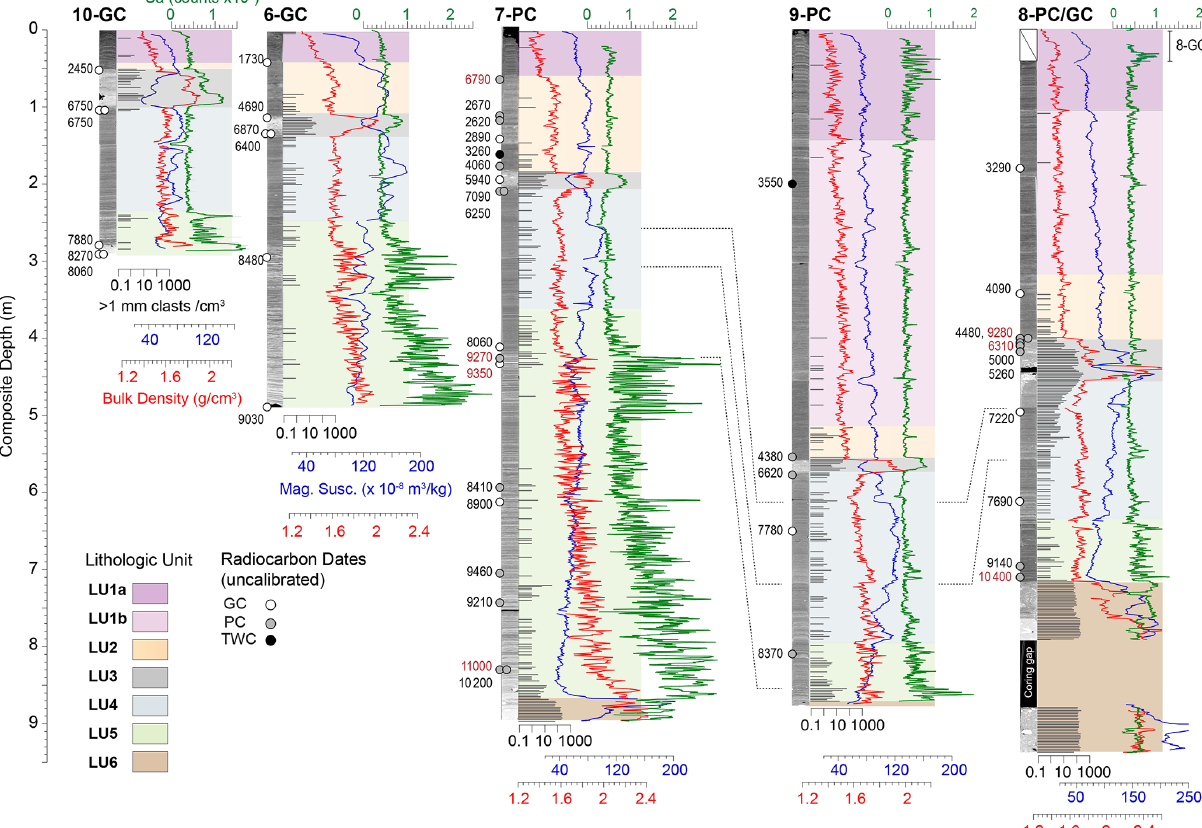
Figure 5. Summary of stratigraphy and correlation of lithologic units between coring stations in Sherard Osborn Fjord. Locations and uncalibrated ages of radiocarbon dates are shown. Key horizons in LU5 and LU4 that can be correlated between 7-PC, 8-PC, and 9-PC are illustrated by thin black lines. Depths for lithologic unit boundaries are provided for each coring station in the